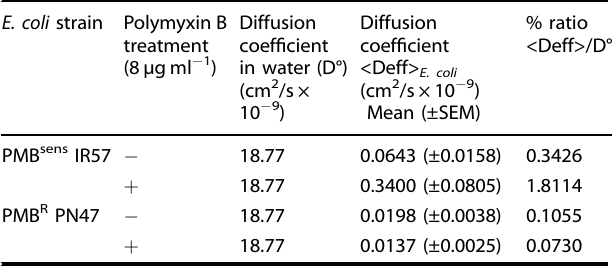
Table 2. NP diffusion within PMB R and PMB sens E. coli bio fi lms ± polymyxin B treatment.